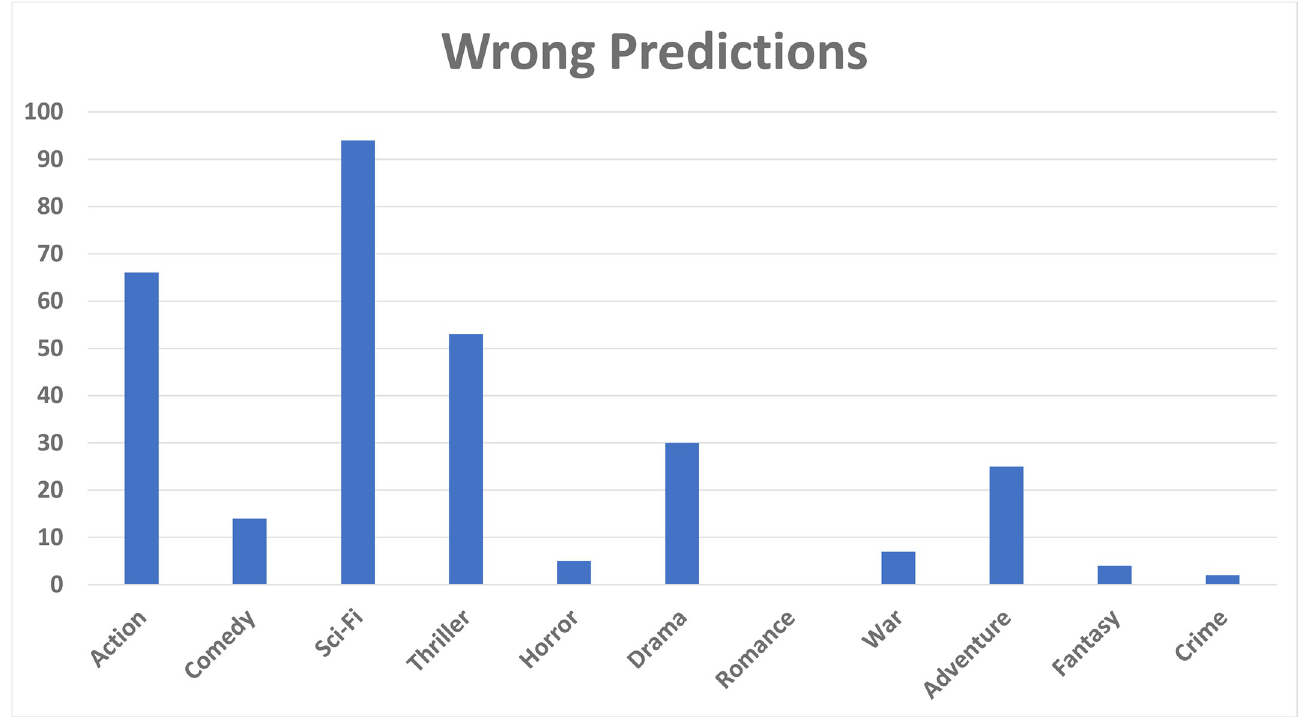
Fig 8. Wrong predictions by